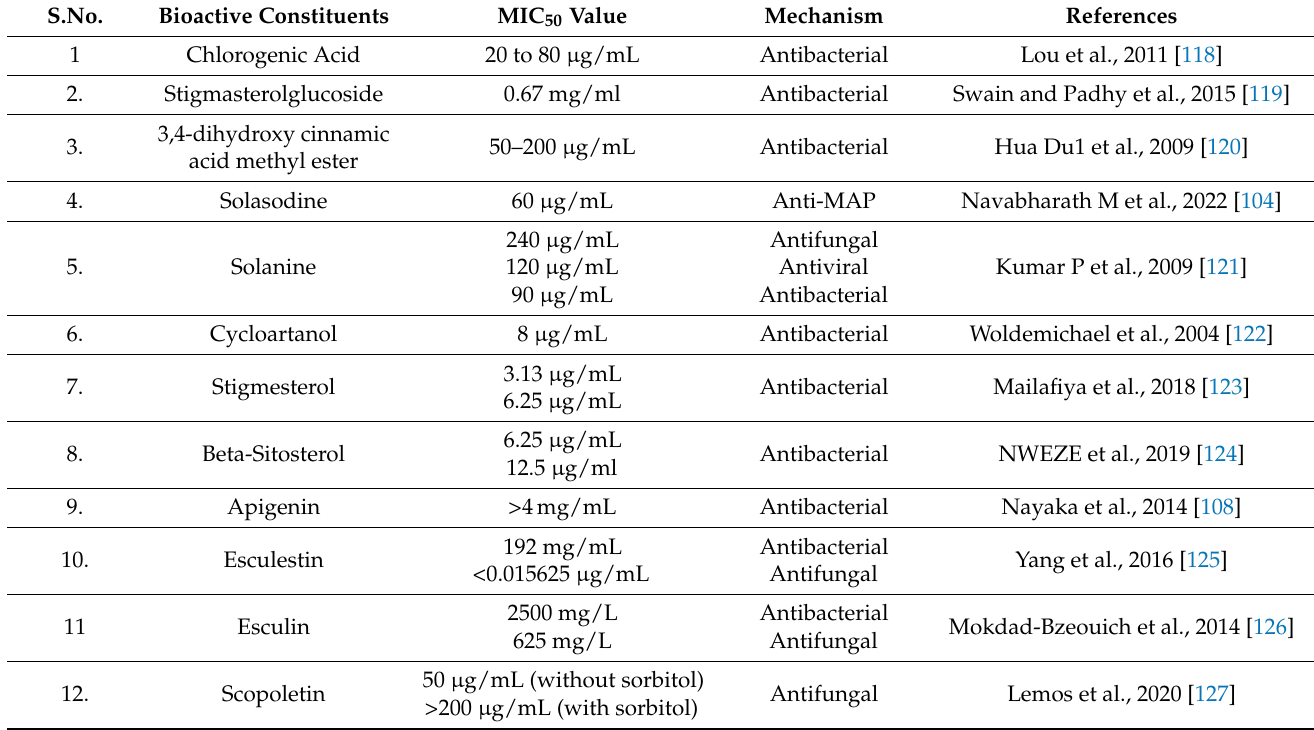
Table 2. Biological mechanism between Bioactive constituents with MIC 50